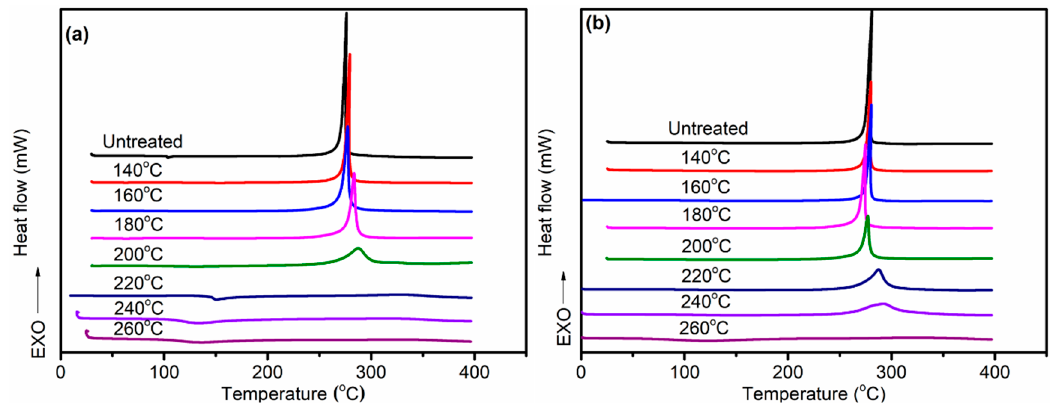
Figure 7. Differential scanning calorimetry (DSC) curves of PAN fibers treated at different temperatures: ( a ) in Sc-CO 2 ; ( b ) in air.